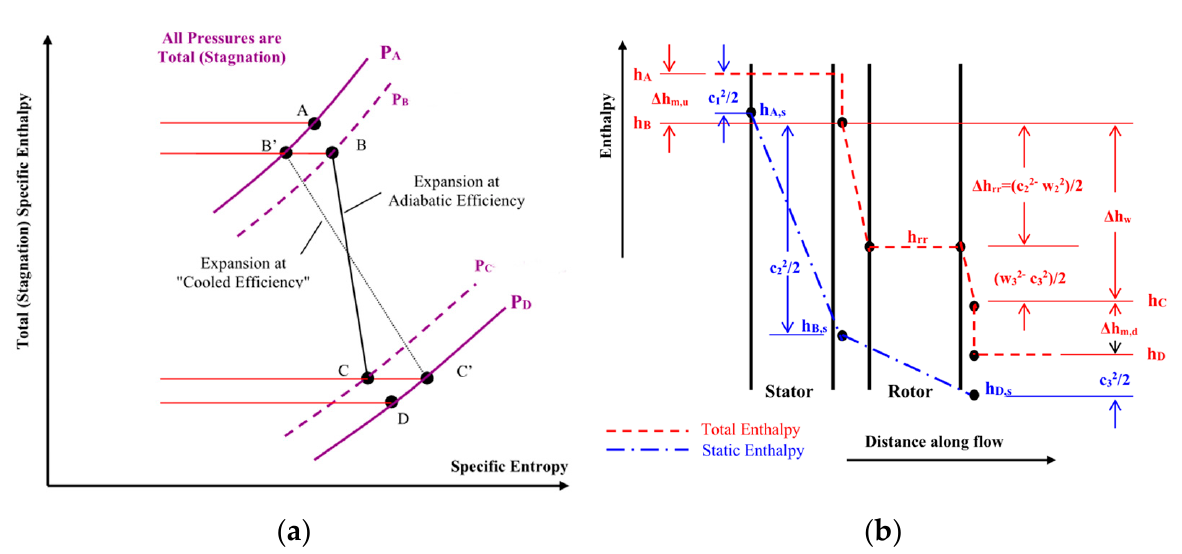
Figure 3. Cooled turbine stage model [34]: ( a ) graphical representation of the expansion line; ( b ) total and static states. Seven cooled turbine stages were used to model the turbine designed by Toshiba [20], and stationary parts. Each stage consists of four cooled elements: stator row, rotor row, forward wheelspace, and aft wheelspace. The endwall cooling flows are included with their associated blade rows. Transition piece leakage flows are included with the